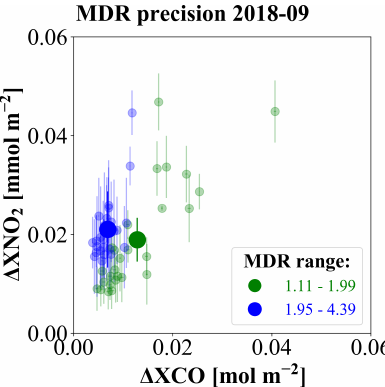
Figure 9. The relationship between daily (cid:49)X CO (molm − 2 ) and (cid:49)X NO 2 (mmolm − 2 ) from TROPOMI for the South American de- forestation (green) and savanna (blue) region for September 2018 using the SBM. The error bars depict the range in (cid:49)X CO and (cid:49)X NO 2 estimates induced by the instrument measurement preci- sion. The range in (cid:49)X NO 2 is larger than (cid:49)X CO because relatively, the X NO 2 instrument precision is less accurate than X CO. The leg- end reports the range of values in the monthly average MDR for both regions.